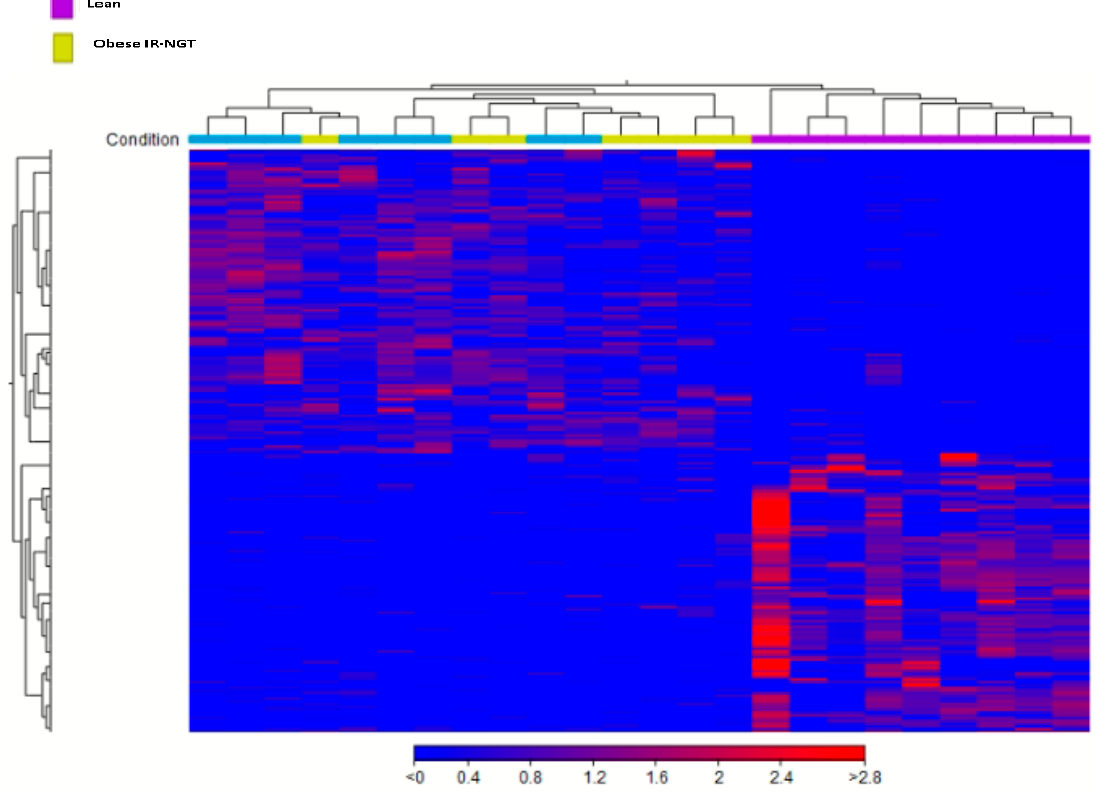
Figure 1. Cluster analysis of most significant DEGs. The abscissa represents different samples n = 25; the vertical axis represents clusters of DEGs. Red color represents upregulation; blue color represents downregulation. Expression data are represented as normalized values. Legend shows the clustering of sample categories purple: lean/control, green: obese T2D, yellow: Obese IR-NGT.